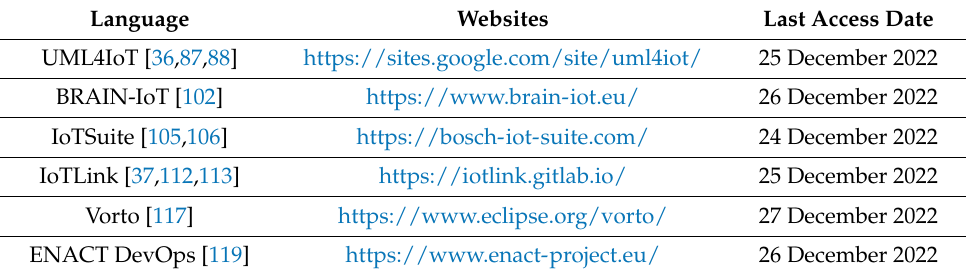
Table 9. The modeling languages for IoT that have accessible